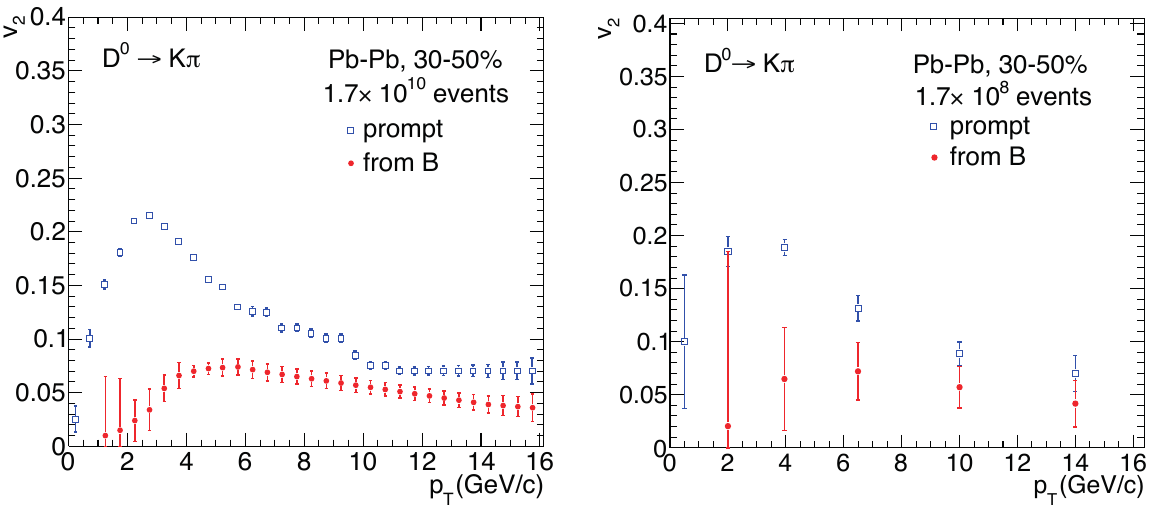
Figure 4. Estimated statistical uncertainties on v 2 of prompt and secondary D 0 mesons for 1 . 7 · 10 10 events (left) in the 30–50% centrality class, which correspond to 10 nb − 1 , and for 1 . 7 · 10 8 events (right), which correspond to about 0.1 nb − 1